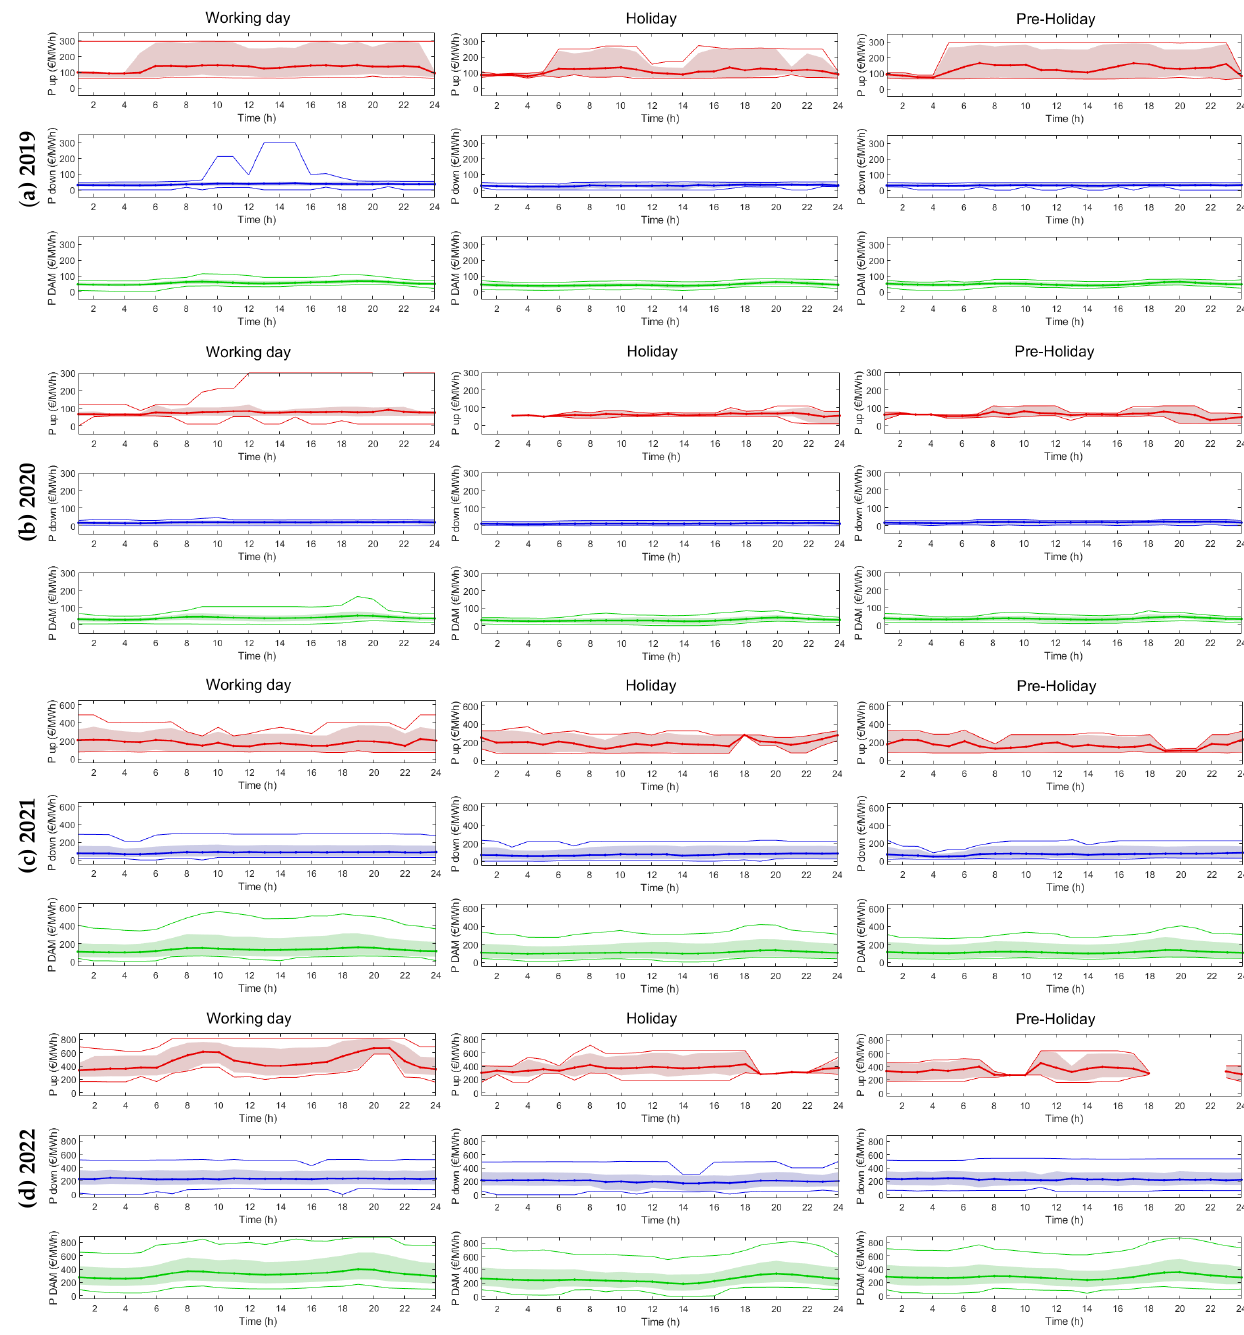
Figure 6. Annual prices trend for Working days, pre ‐ Holidays, and Holidays of years 2019 ( a ), 2020 ( b ), 2021 ( c ), and 2022 ( d ).